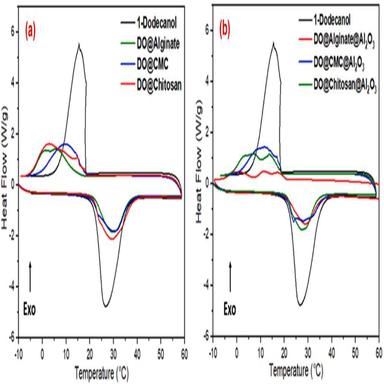
DSC graphs of 1-Dodecanol and EPCMs (a) without and (b) with nano-Al2O3.